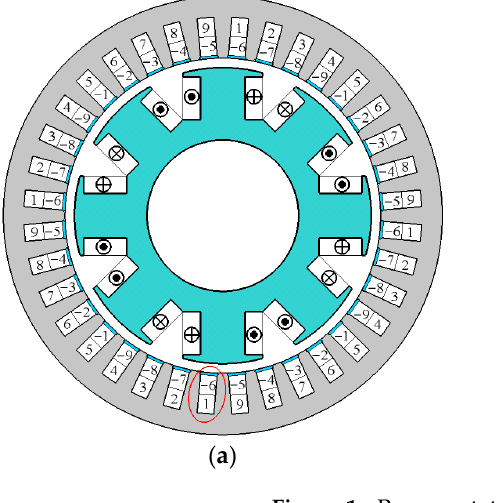
Figure 2. Open type stator slot sketch. Figure 3. Scheme of the nine ‐ phase inverter with an additional DC chopper. The numbers show the order of the motor phases.